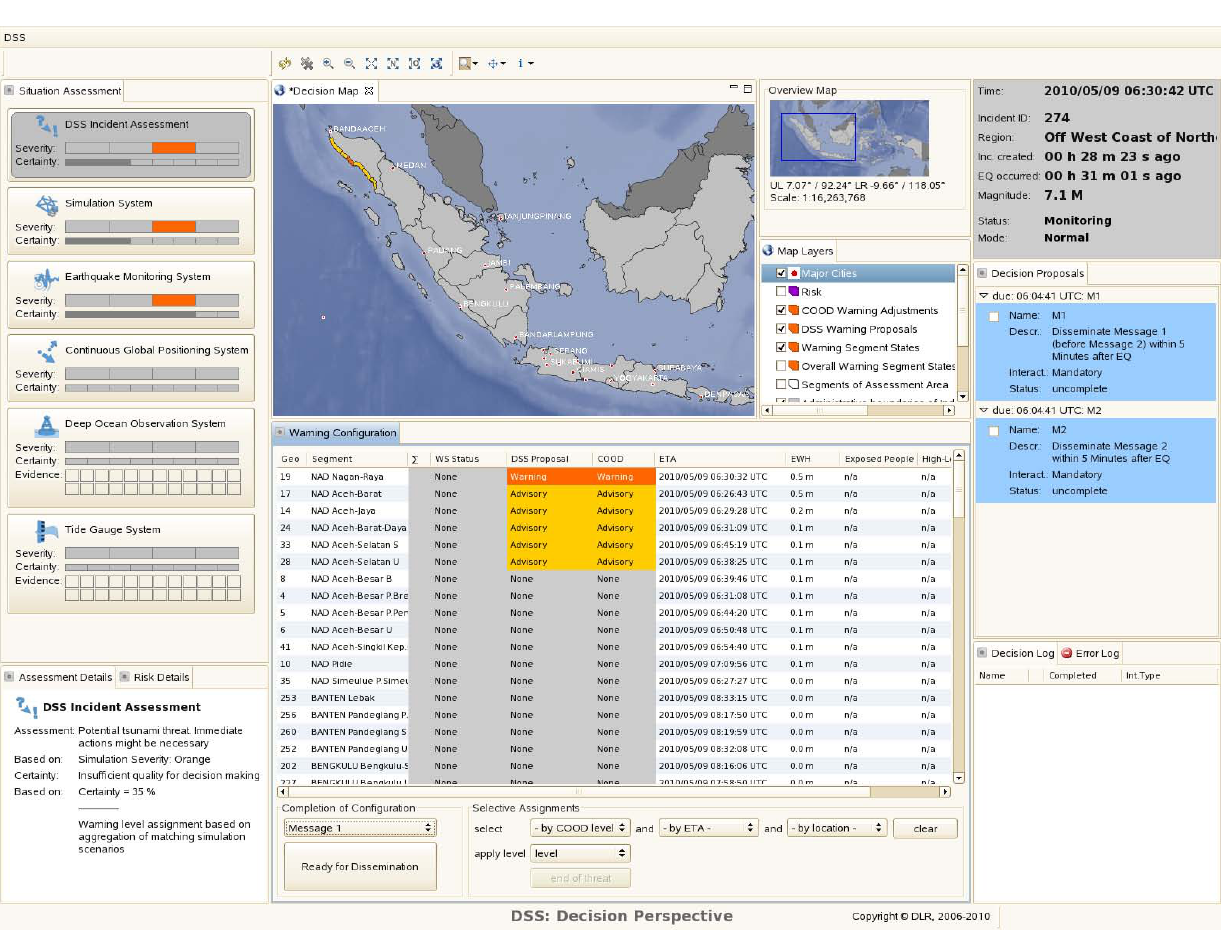
Fig. 6. Integration of Risk and Vulnerability Information in the Decision Perspective . The map shows the individual risk and the table lists numbers for “exposed people” and “high-loss infrastructure” for each affected warning segment. Each warning segment in the list is additionally color coded for the warning level and the overall